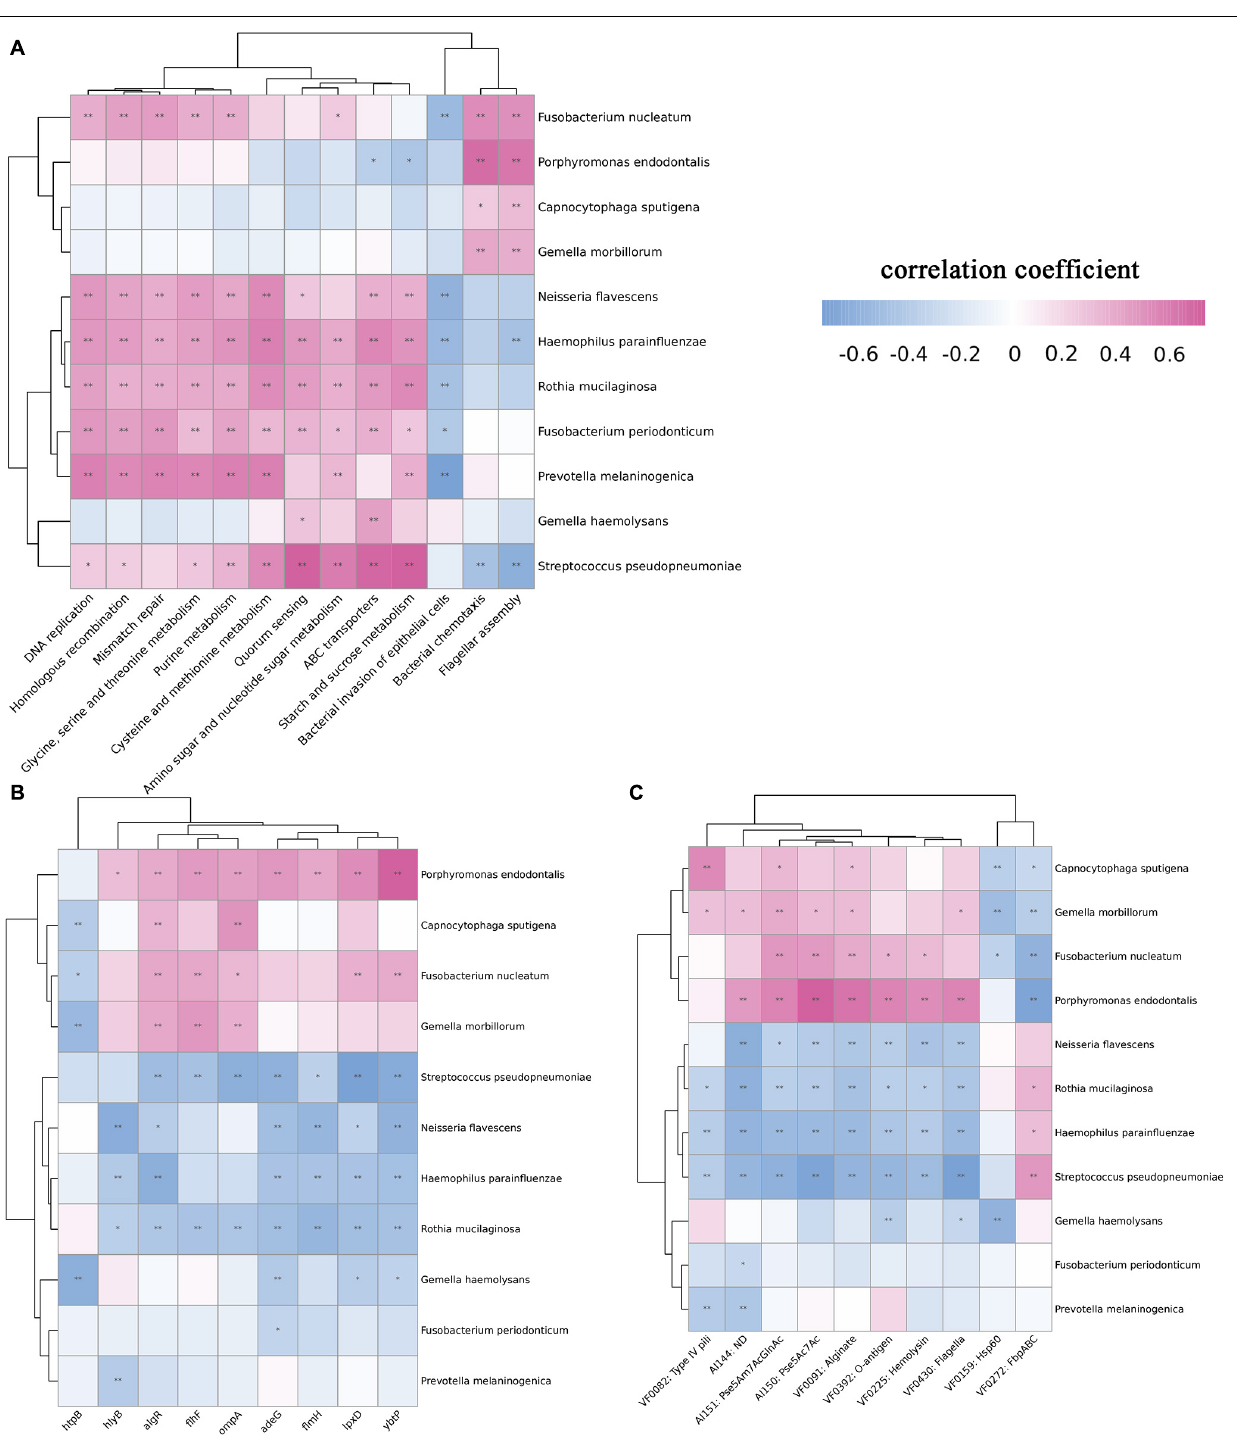
Frontiers in Microbiology |